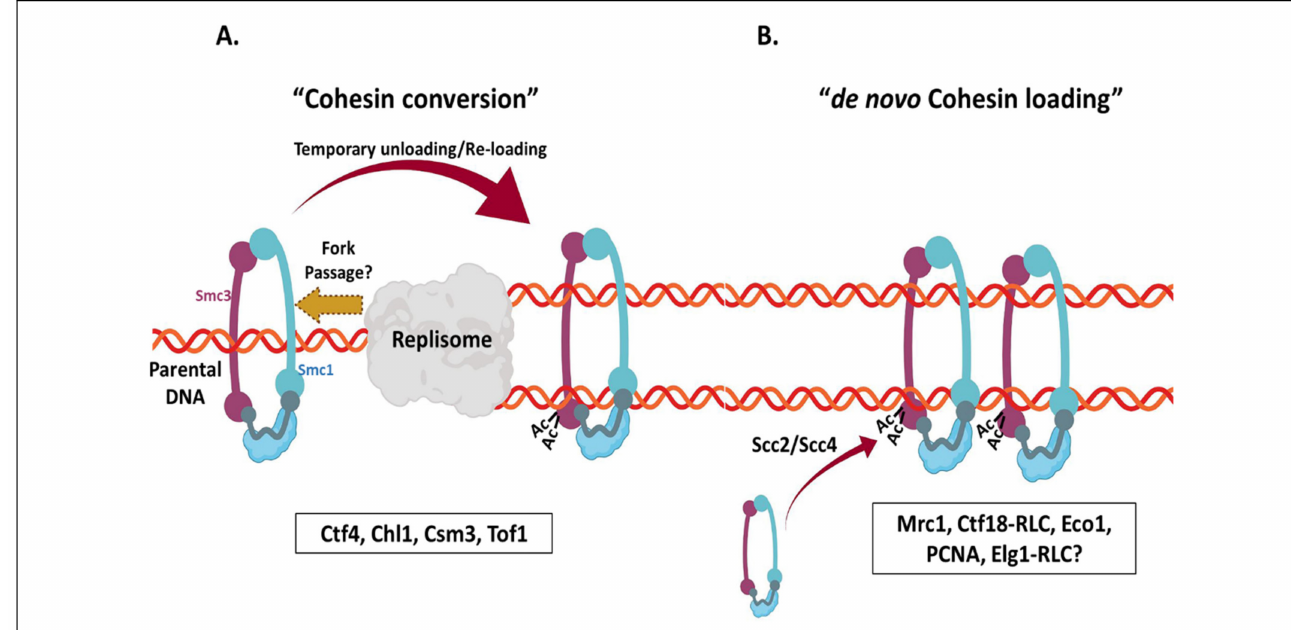
Figure 3. Two replication-coupled cohesion establishment pathways. ( A ) Cohesin conversion pathway: The cohesin rings already loaded onto the chromatin in late G1 phase are converted into a cohesive form in two possible ways. In the first scenario, the cohesin rings are temporarily detached from the chromatin and shifted behind the replication fork, resulting in SCC. The second scenario involves the replication fork passage through the cohesin ring. The factors essential for the cohesin conversion pathway are mentioned below the illustration. ( B ) De novo cohesin loading: The second pathway involves the loading of new cohesin rings onto the replicated sister chromatids in an Scc2/Scc4-dependent pathway. The Ctf18-RLC loads PCNA on the leading strand, which promotes Eco1 activity to allow cohesion establishment. The Elg1-RLC appears to be part of a cohesin loading pathway. However, further studies are required to understand its function in